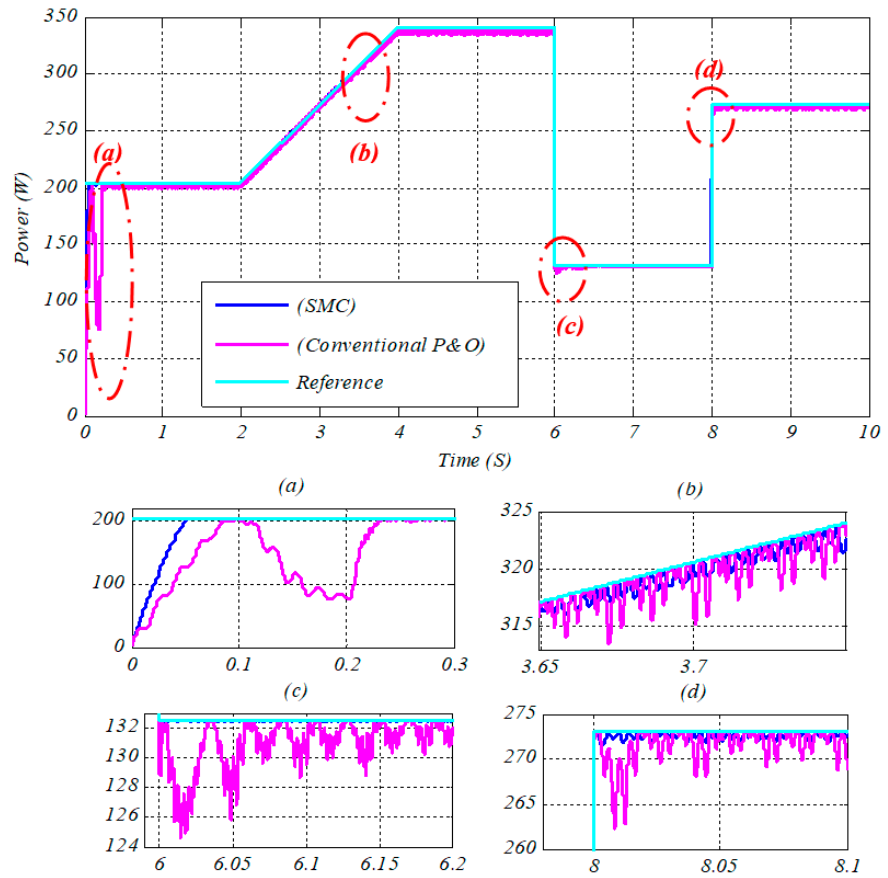
Figure 1 6. Output PV Power waveform under variable illumination. Figure 16. Output PV Power waveform under variable illumination. Energies 2018 , 11 , x FOR PEER REVIEW